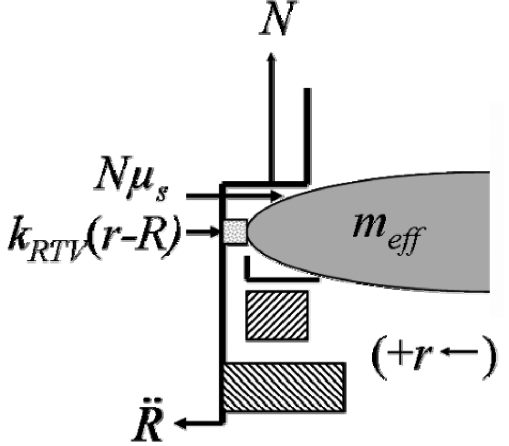
Fig. 2. (SDOF) mass-spring